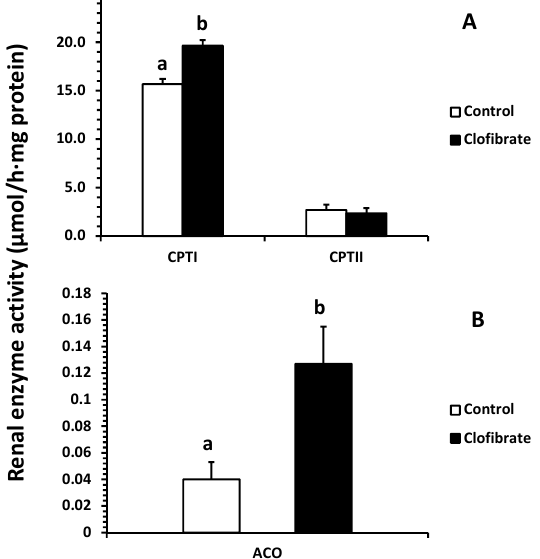
Figure 4. Effects of oral clofibrate on renal enzyme activity in neonatal pigs. Values are least square means ± SEM ( n = 5). CPT I and CPT II, carnitine palmitoyltransferase I and II ( A ), and ACO, acyl-CoA oxidase ( B ). Columns with different letters are different ( p < 0.05).